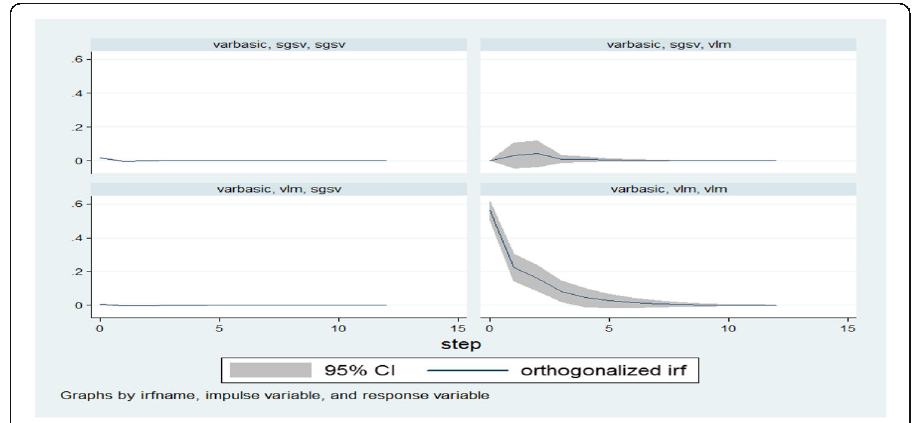
Fig. 2 Impulse-Response Function Analysis